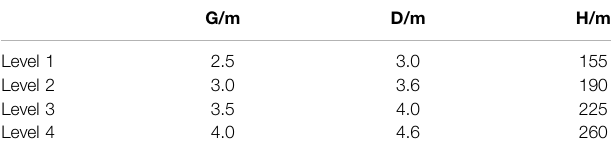
TABLE 2 | Four levels for research k 2 .